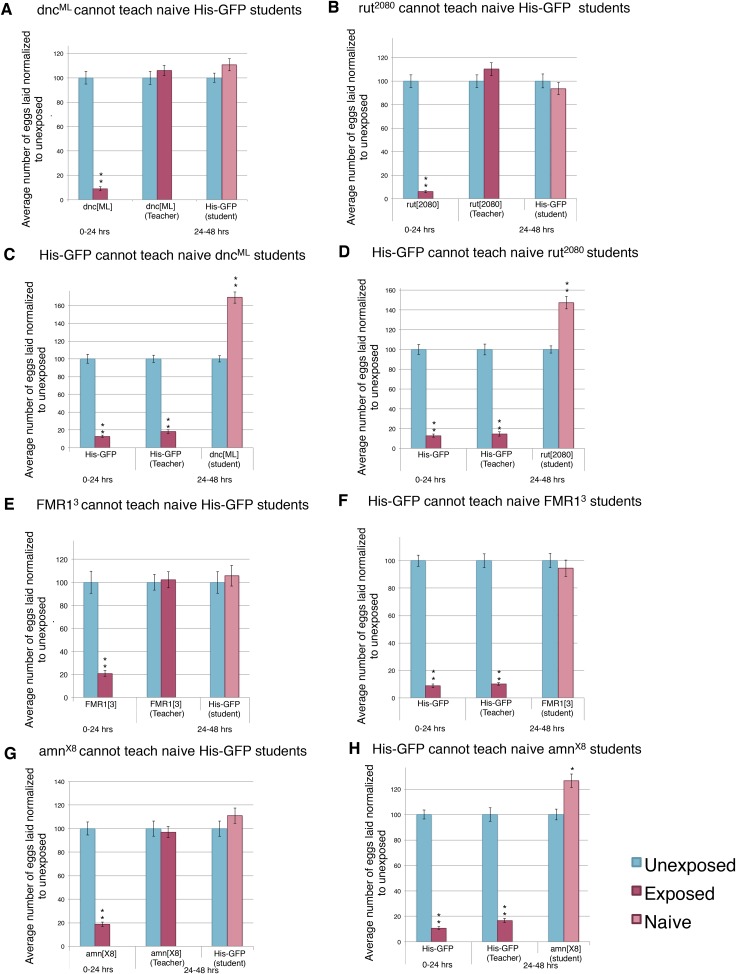
Learning mutants are unable to teach or be students.(A to H) Percent of eggs laid normalized to unexposed. (A and C) dncML as teacher and student. (B and D) rut2080 as teacher and student. (E and F) FMR13 as teacher and student. (G and H) amnX8 as teacher and student. Error bars represent standard error (n= 24 biological replicates) (**p < 1.0e-5).